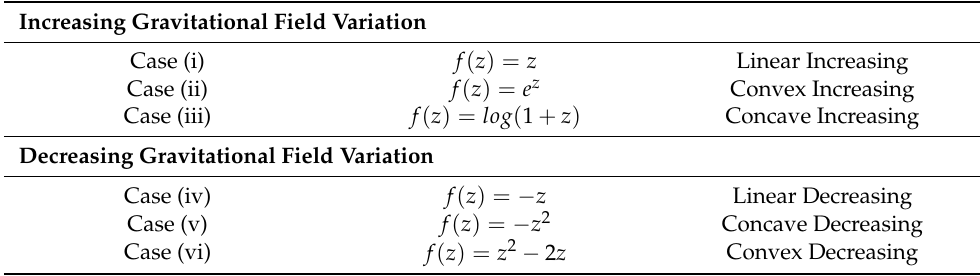
Table 2. Different cases for gravitational field